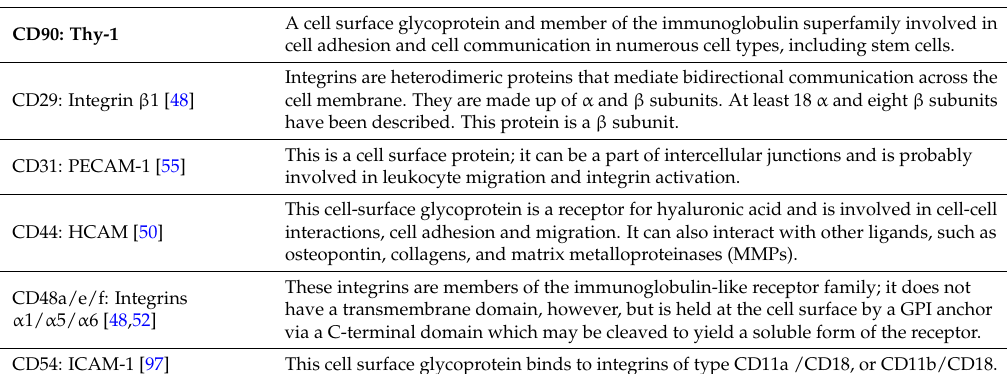
Table 2. The cell surface molecular profile of human MSCs; an overview of different molecules. The molecules suggested to be used for identification of MSCs are marked in